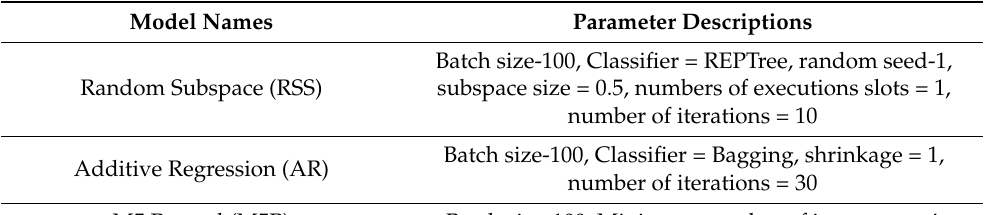
Table 2. The parameters of the machine learning algorithm in modeling SPEI-6, -9, -12 and -24.